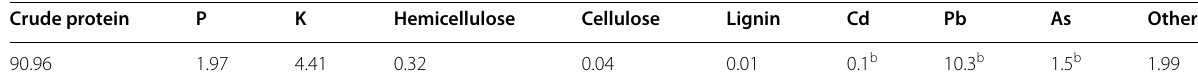
Table 3 Composition of CPH II powder (%) Crude protein Based on dry matter a Alkali metals such as Na and Mg, sugars such as glucose and fructose b In ppm